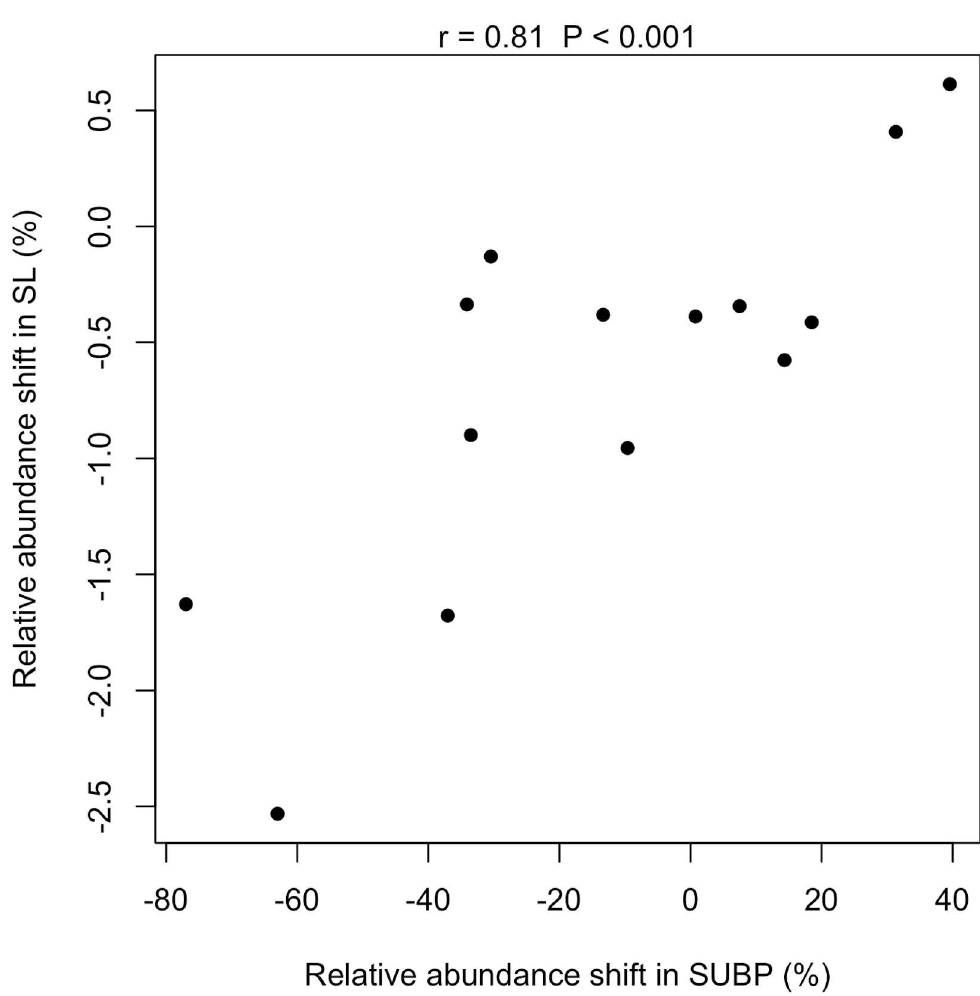
Fig 4. Correlation of total relative abundance shift of the 12 SUBP-specific OTUs in SUBP samples with that in SL samples following periodontal therapy. The Pearson correlationcoefficient (r) and the P value are shown in the upper side of the